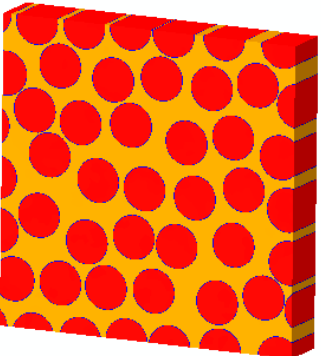
Figure 4. Fiber random distribution microscale RVE considering interface.